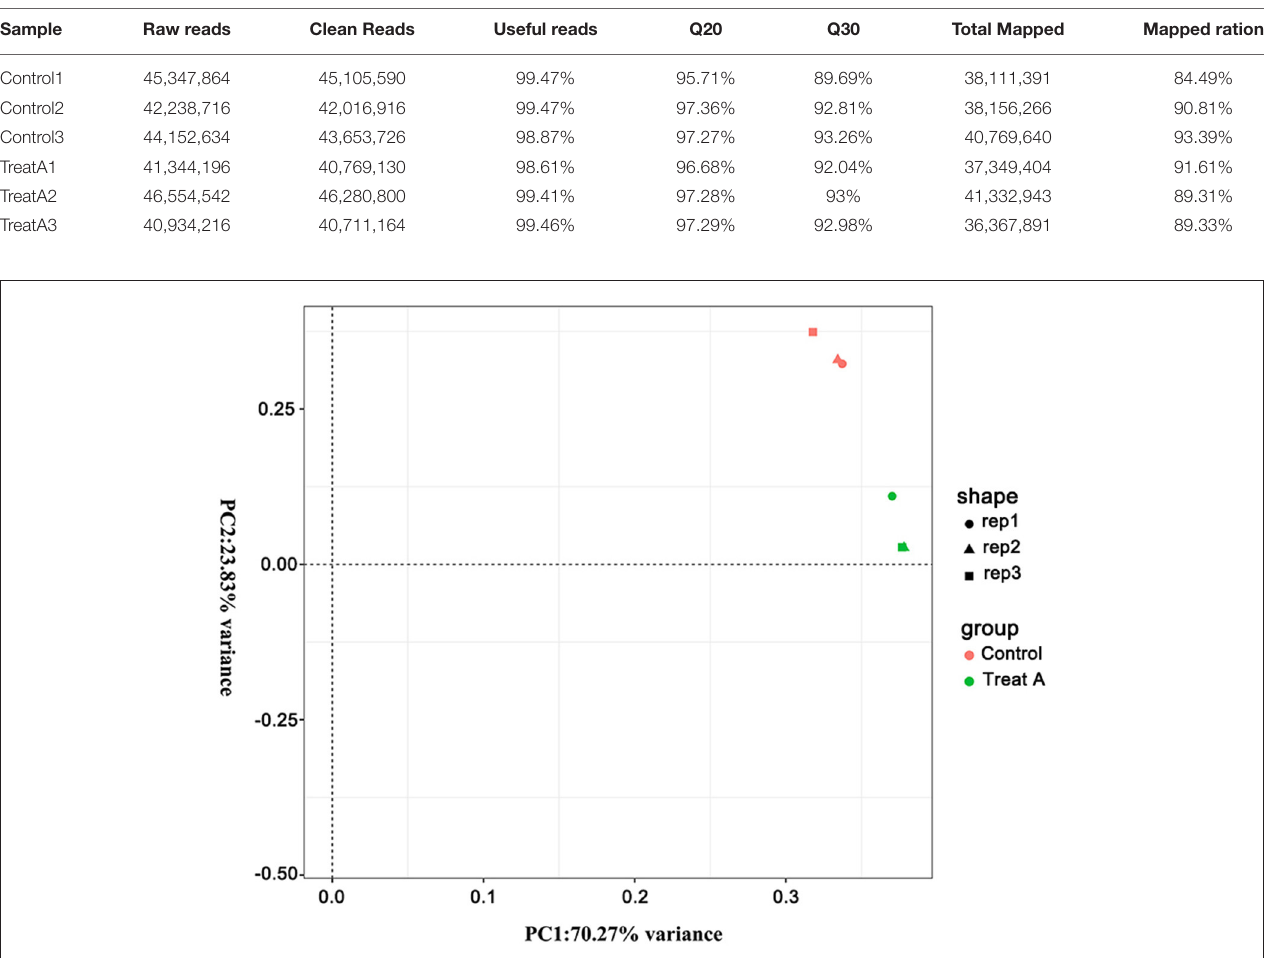
Frontiers in Nutrition |